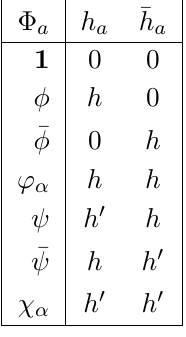
Table 1 . Some of the primary (cid:12)elds occurring on the defect ( r;